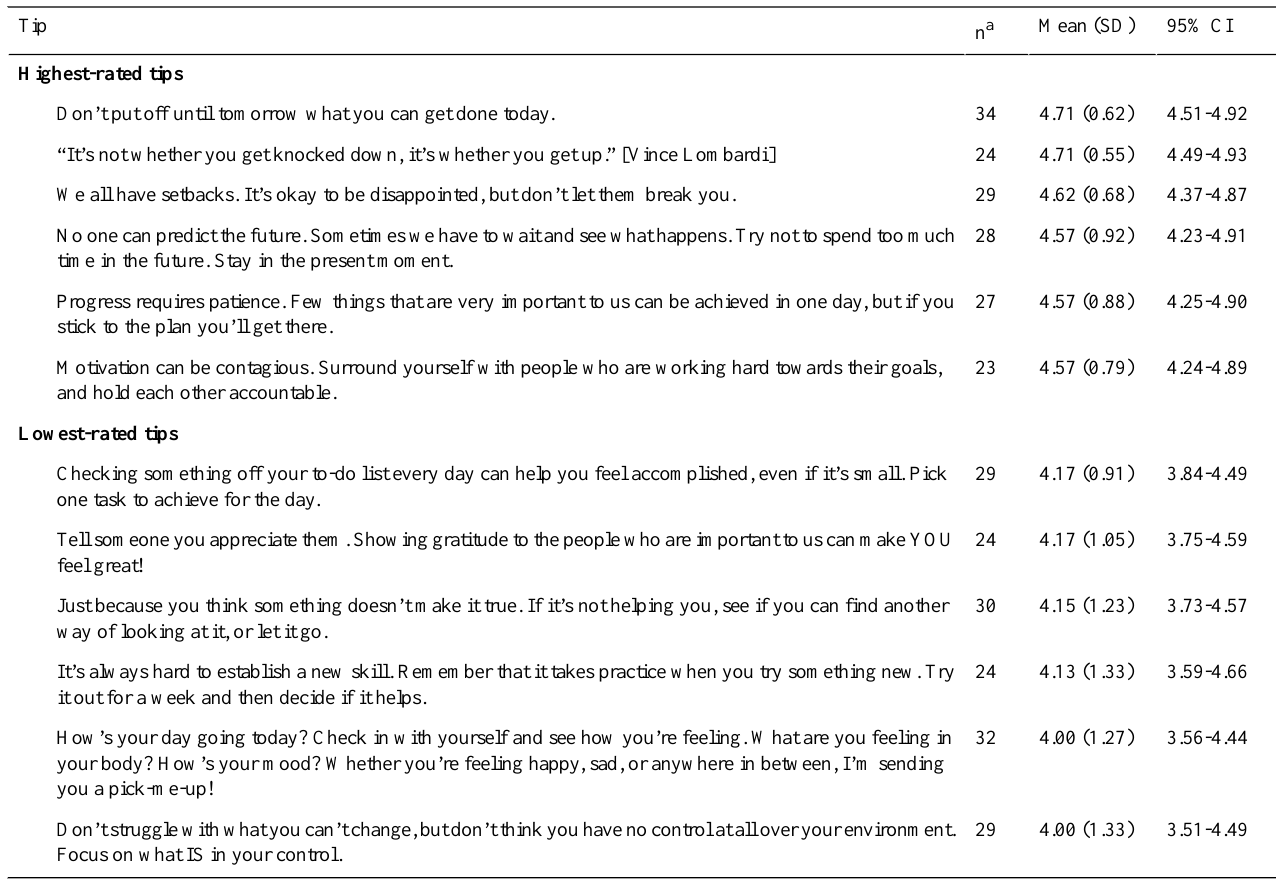
Table 4. Tip rating descriptive statistics (in order of